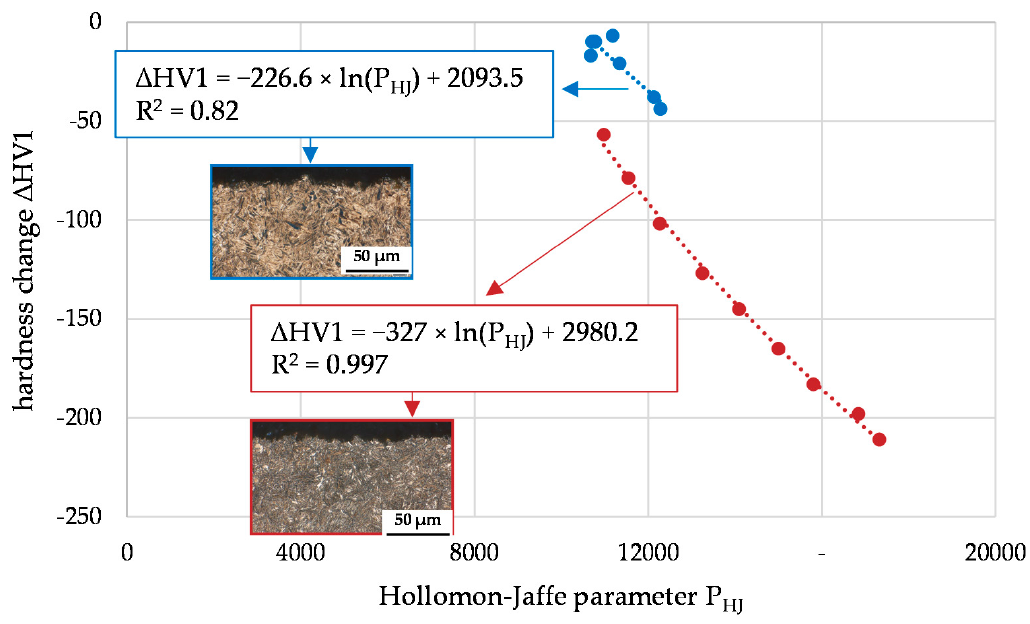
Figure 14. Hardness change dependent on the Hollomon–Jaffe parameter in consideration of metallographic cross-section analysis (blue: no visible heat-affected zone; red: visible heat-affected zone).